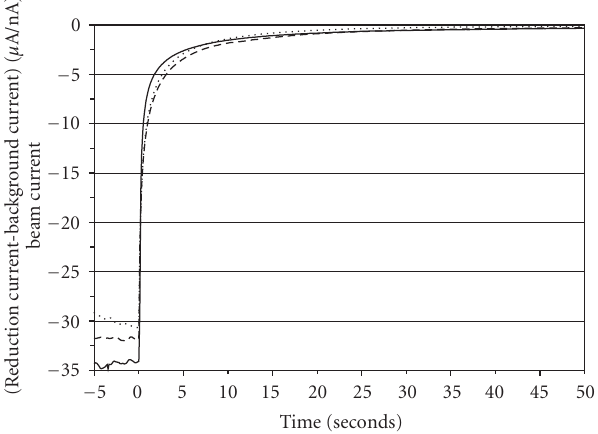
Figure 8: Electrochemical current “tails” after exposure of a 0.01M KOH to alpha radiation indicating collection of O 2 /H 2 O 2 that has di ff used away from the electrode after exposures of di ff erent durations. Dotted: 10 sec exposure, dashed: 30 seconds, and solid: 58 seconds.